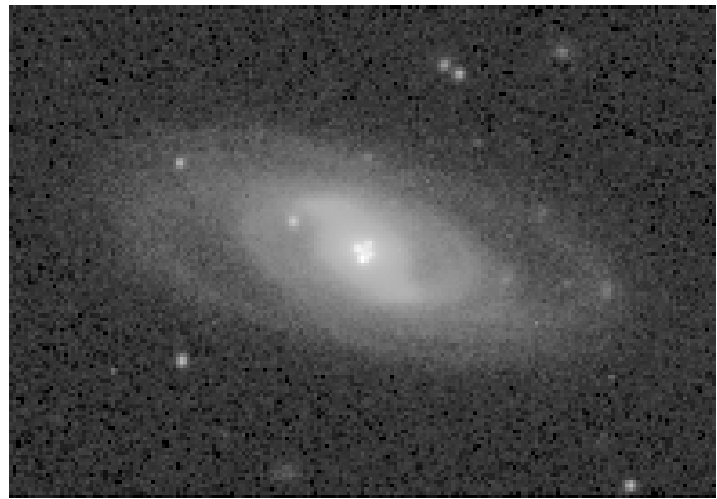
Fig. 1. Four images of QSO B2237+0305 seen through the bulge of a galaxy. moving under the magnification